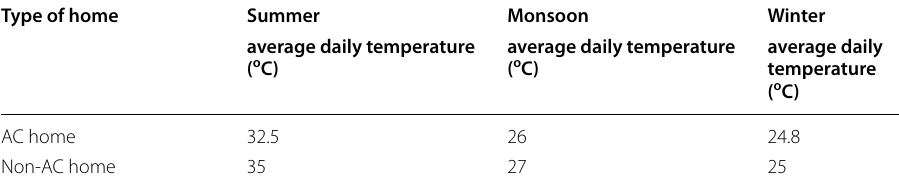
Table 5 Average indoor temperature per day of AC and non-AC homes for each season Type of